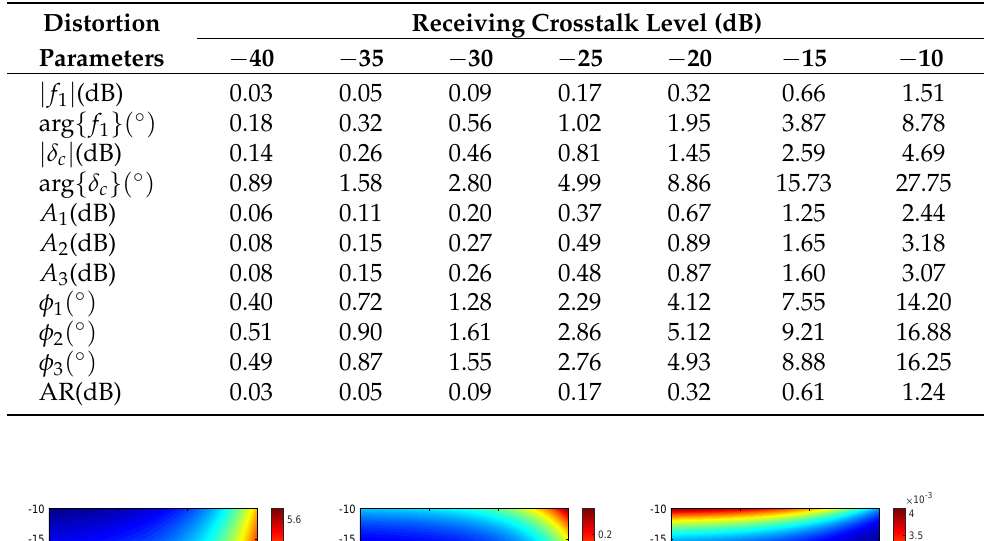
Table 2. The maximum estimation error of the distortion parameters obtained using the CCT scheme under different crosstalk levels.